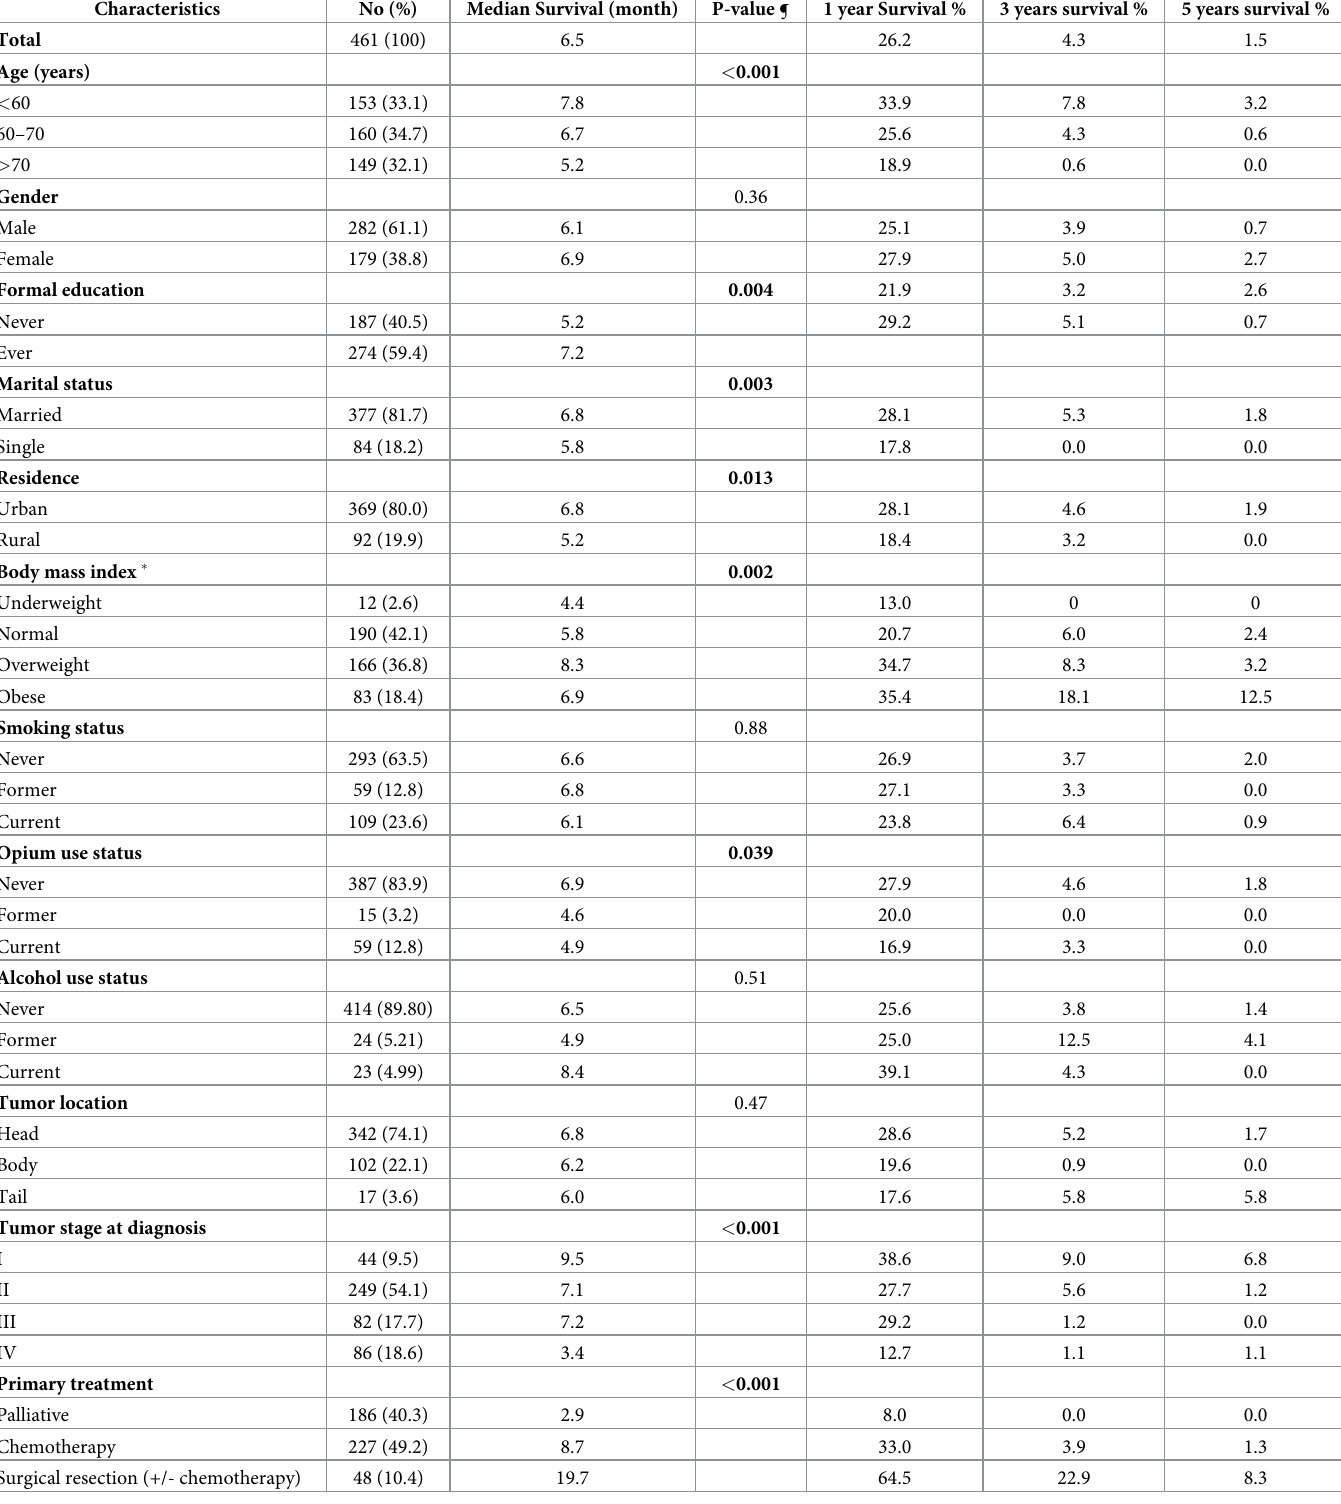
Table 1. Estimates of overall survival rates by demographics and tumor characteristics among Iranian patients with pancreatic ductal adenocarcinoma.